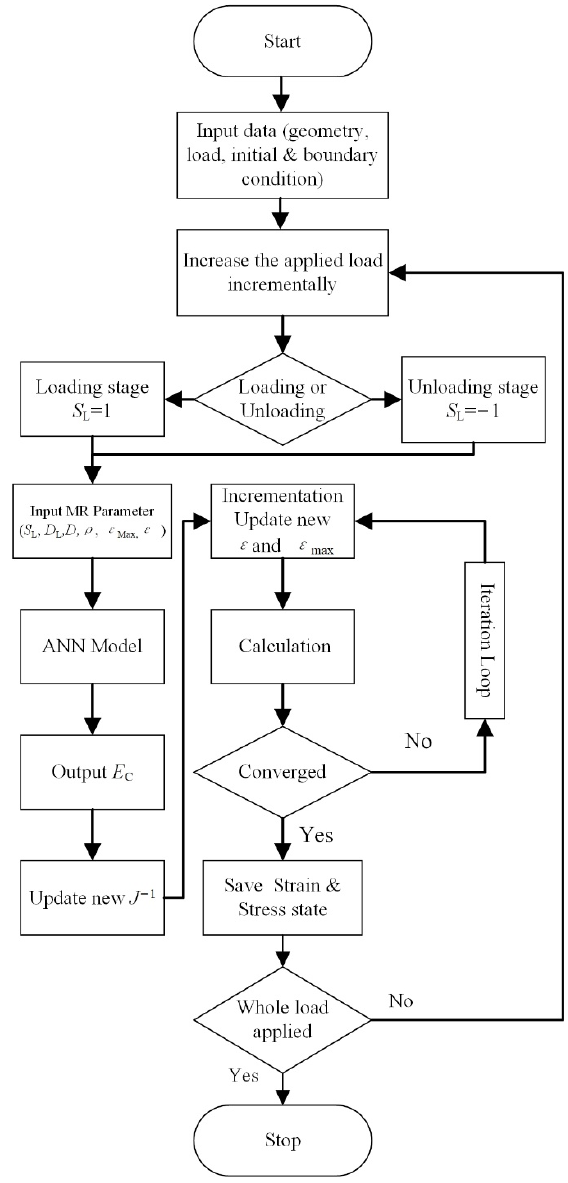
Figure 10. Flow chart of the calculation procedure.